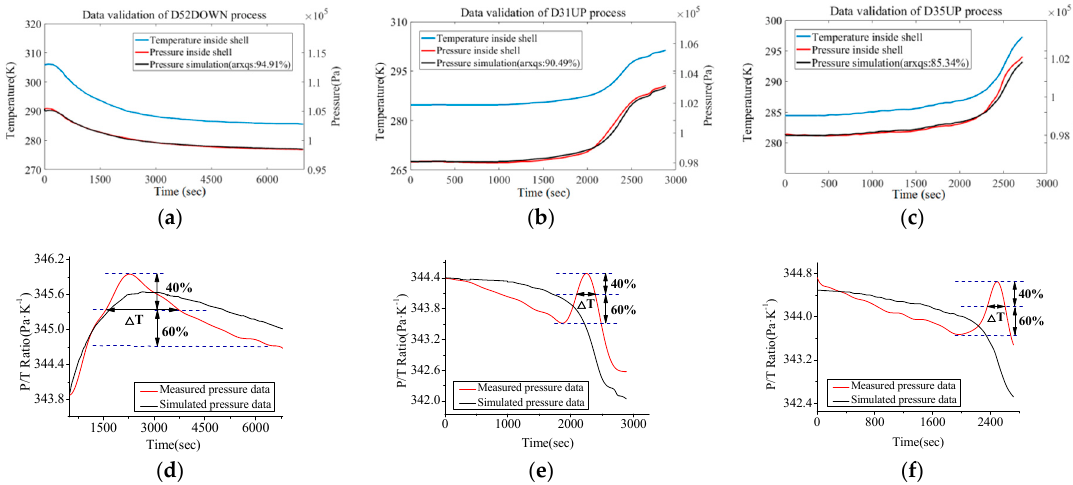
Figure 8. Data validation between real measurement group and predicted simulation group ( T c - P ).